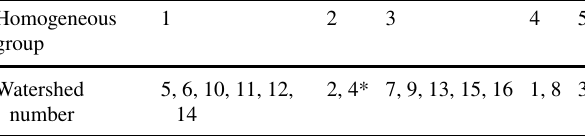
Table 2 Homogeneous watersheds within the urban area of Arak (4*)